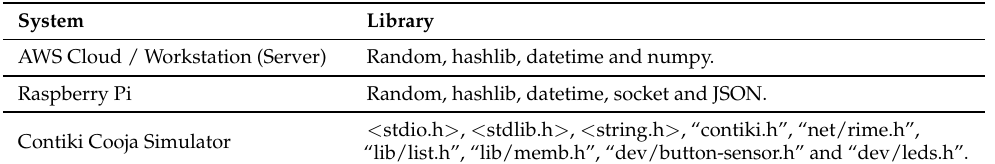
Table 3. Libraries used in the different